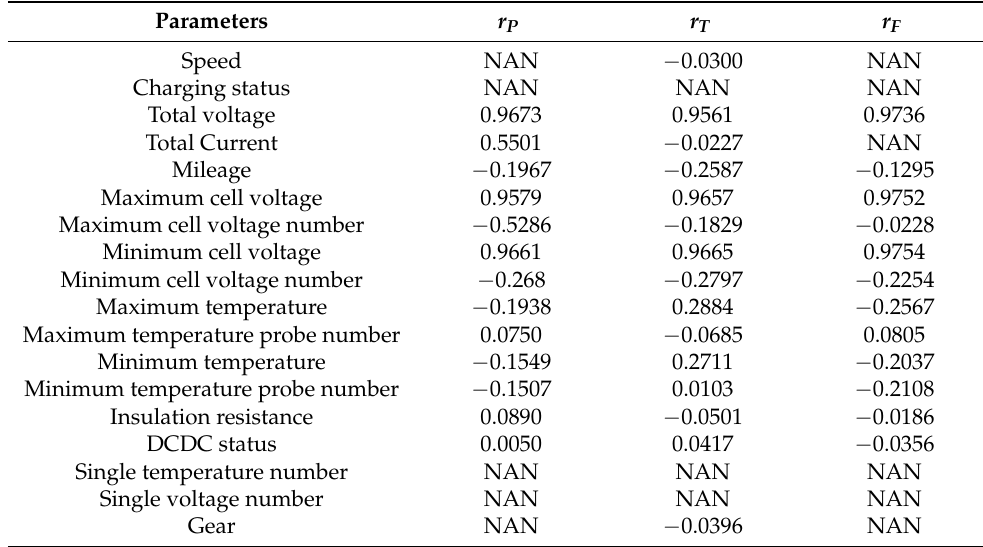
Table 2. Pearson analysis with parameters related to the SOC for working